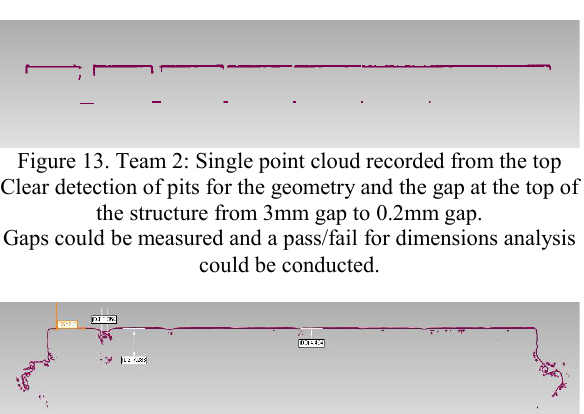
Figure 14. Team 3: the 3mm gap could be detected, and some further indentations which did not count as proper gap.